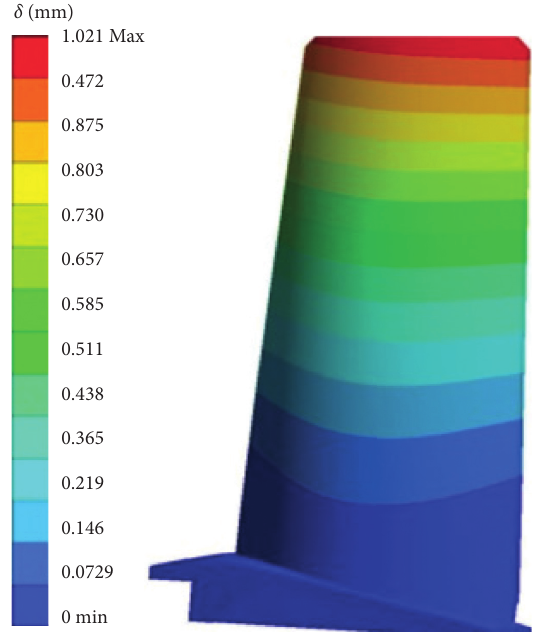
Figure 3: Blade deformation distribution.